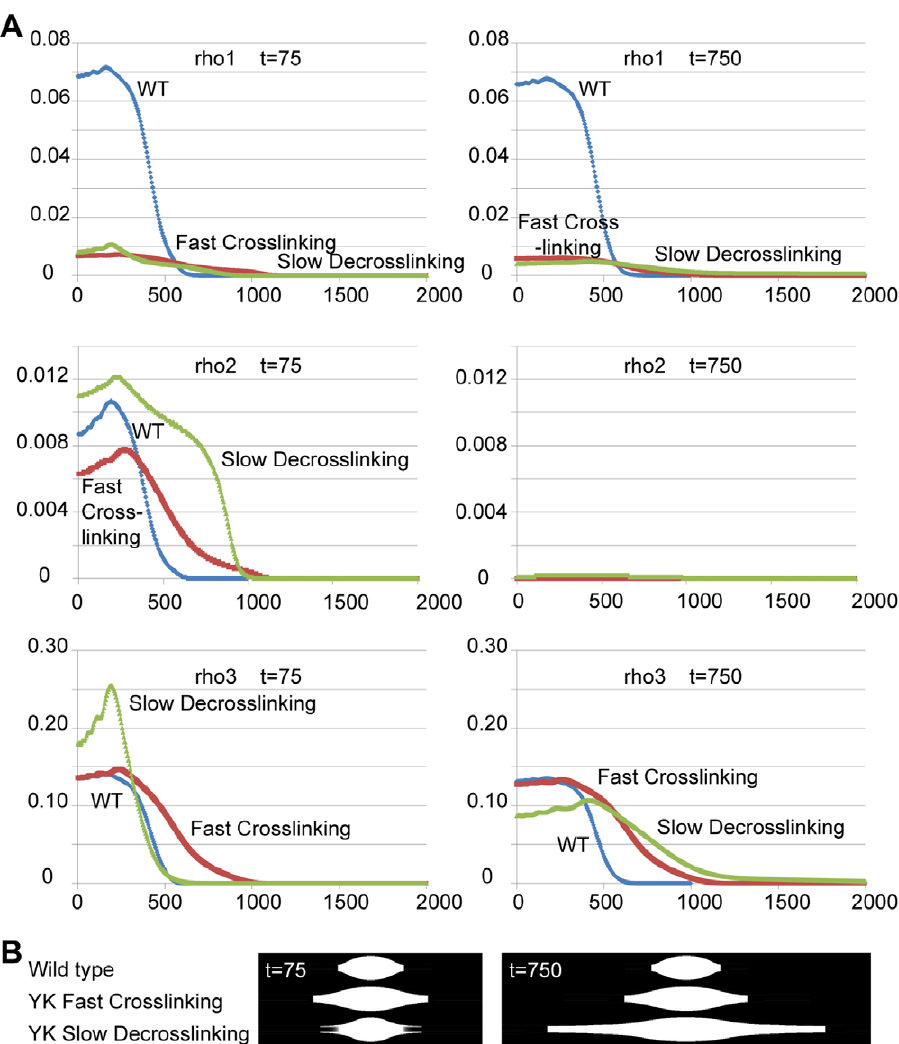
Figure 6. Simulations of NcdY485K mutant effects on MI spindle assembly. (A) Relative microtubule densities (Y axis) versus relative distance from the spindle equator (X axis) in simulations modeling the 11-fold higher microtubule affinity of the NcdY485K mutant as 11-fold faster crosslinking (red) or as 11-fold slower decrosslinking (green), both with 2-fold increased sliding rate to account for faster motility; results for wild-type parameters [18] are shown for comparison (blue). Densities are shown at an early stage of spindle assembly (t=75, left) and in fully formed spindles (t=750, right). Top: rho1, unaligned (uncrosslinked) microtubules; middle: rho2, primarily crosslinked microtubules aligned with the long spindle axis, involved in sliding to elongate the spindle; bottom: rho3, microtubules crosslinking different chromosomes, essential for proper spindle shape. (B) Diagrams from the simulations representing spindles at time t=75 and t=750.